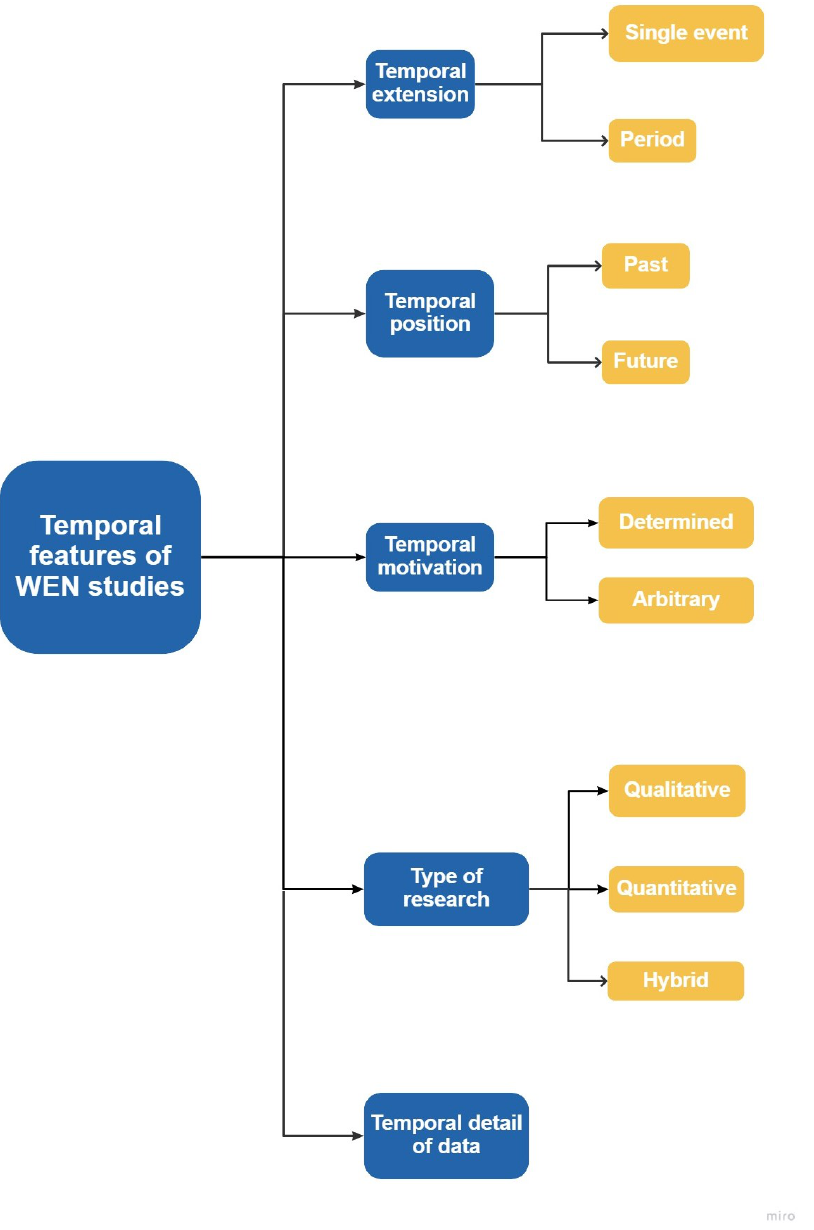
Figure 3. Conceptual framework applied to analyze the temporal features of WEN